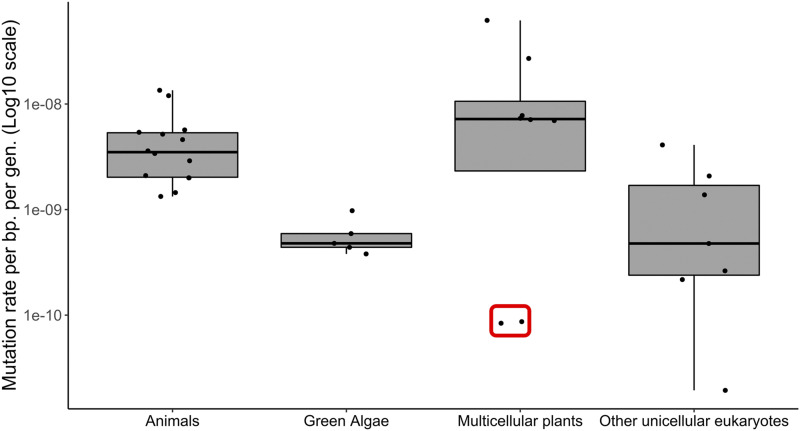
Comparison of per base pair, per generation mutation rates between duckweed and other eukaryotic species. Duckweed estimate highlighted by red box. References: (Ossowski et al. 2010; Lynch 2010; Denver et al. 2012; Schrider et al. 2013; Weller et al. 2014; Zhu et al. 2014; Venn et al. 2014; Keightley et al. 2015; Uchimura et al. 2015; Yang et al. 2015; Farlow et al. 2015; Ness et al. 2015; Smeds et al. 2016; Xie et al. 2016; Besenbacher et al. 2016 p.; Feng et al. 2017; Liu et al. 2017; Oppold and Pfenninger 2017; Flynn et al. 2017; Krasovec et al. 2017, 2018, 2019; Hanlon et al. 2019; Orr et al. 2020).